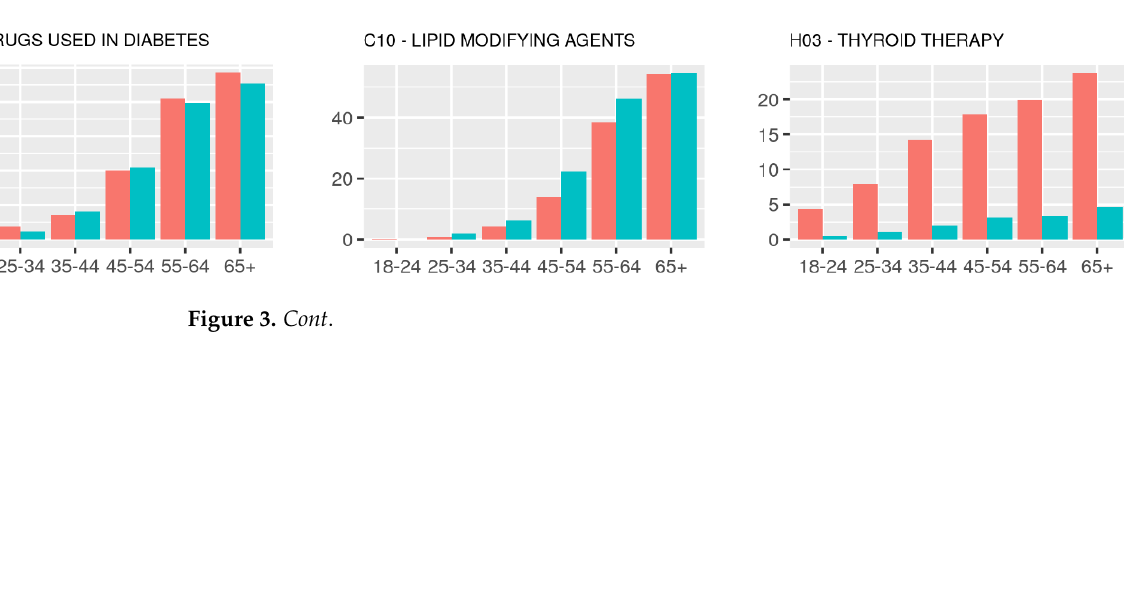
Figure 2. Counts of drugs taken by 6000 QBB participants, ordered by ATC therapeutic subgroup.